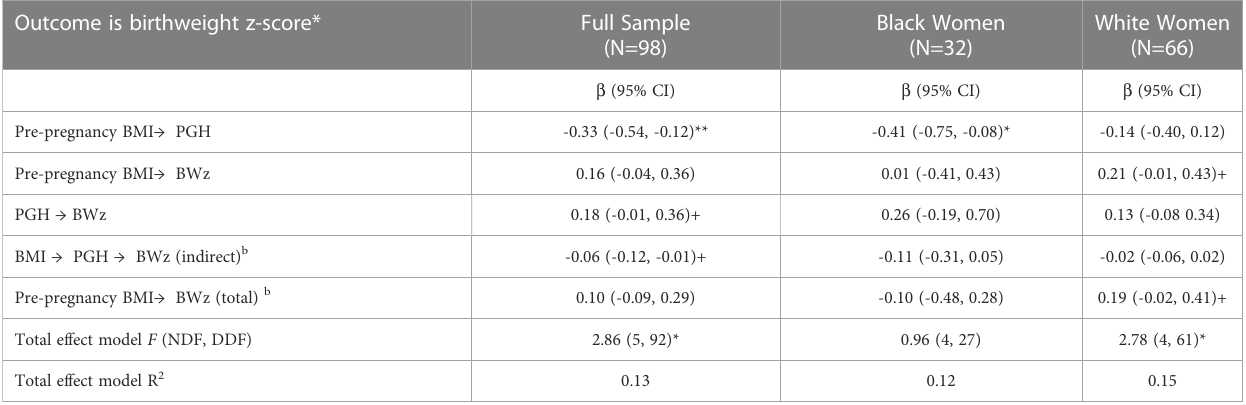
TABLE 6 Testing cascading effects of maternal pre-pregnancy BMI on infant BWz through PGH a . Outcome is birthweight